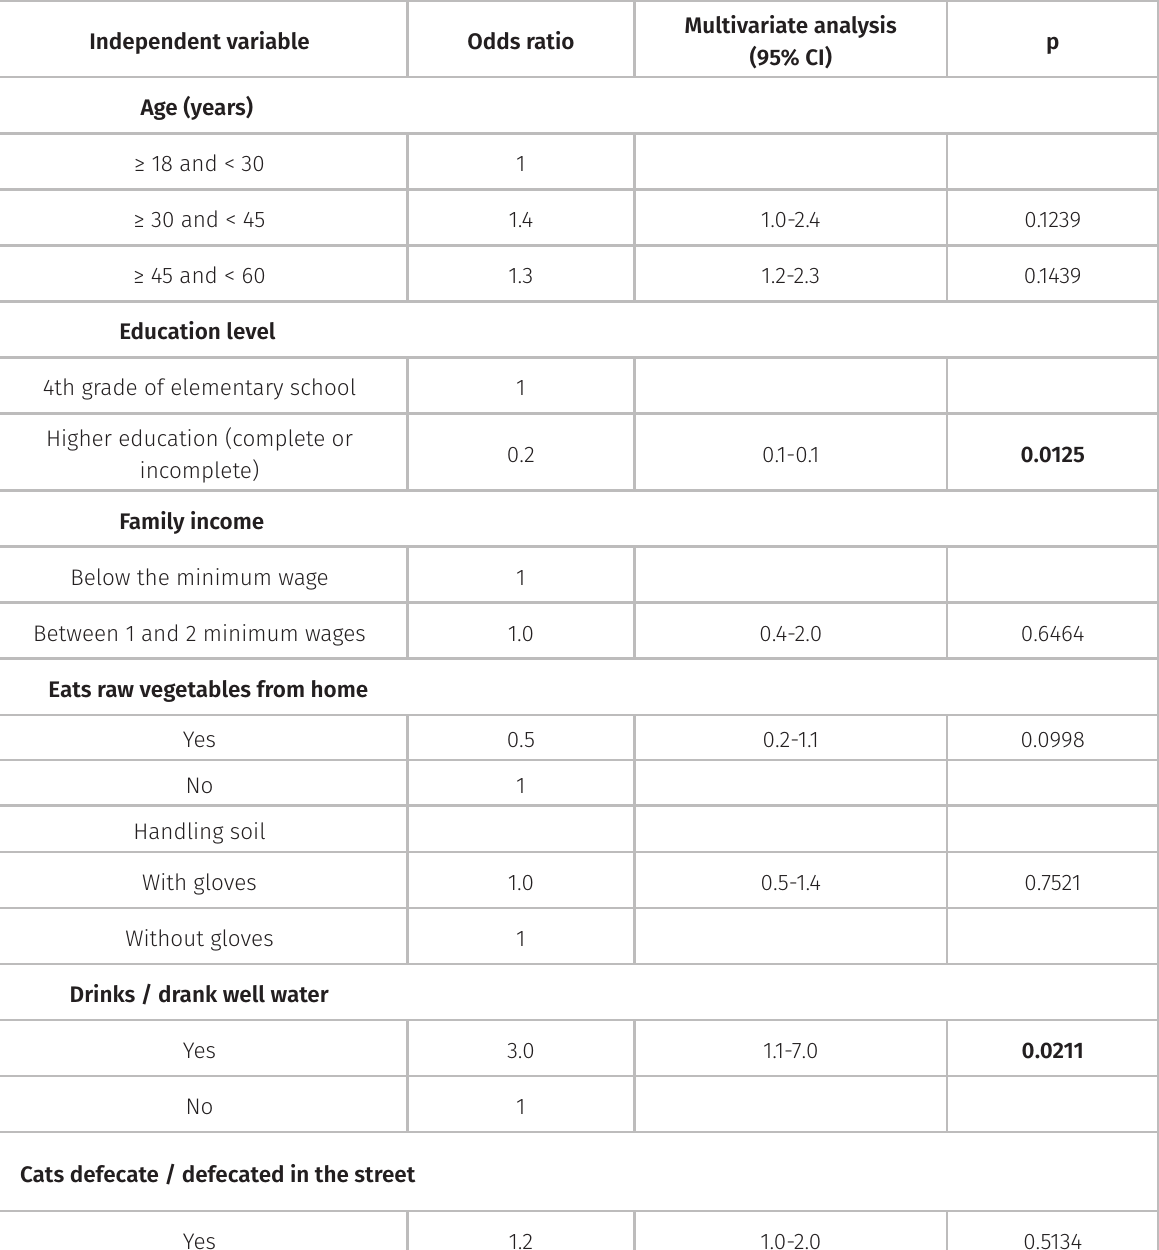
Table V. Multivariate analysis of aspects associated with T. gondii infection in patients who were attended by the Expert Assistance Service of Foz do Iguaçu city, Paraná state, Brazil, in